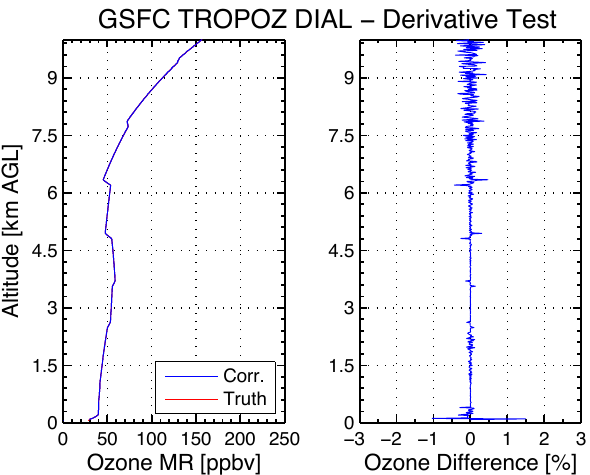
Figure 2. The left panel shows the initial retrieved ozone concen- tration from the TROPOZ algorithm using the Savitzky–Golay dif- ferentiation filter for the numerical derivative as compared to the known ozone profile used in the simulated lidar return signals. The right panel shows the percent difference from the known profile and retrieved